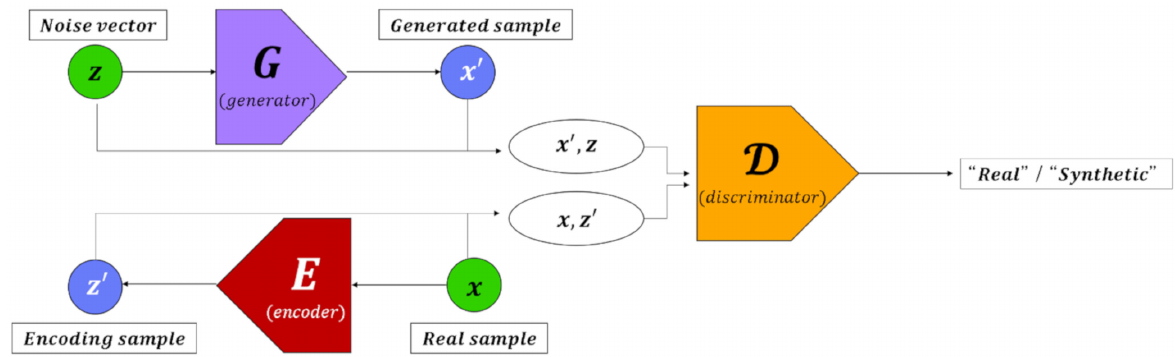
Figure 11. Structure of GAN with the addition of the inference